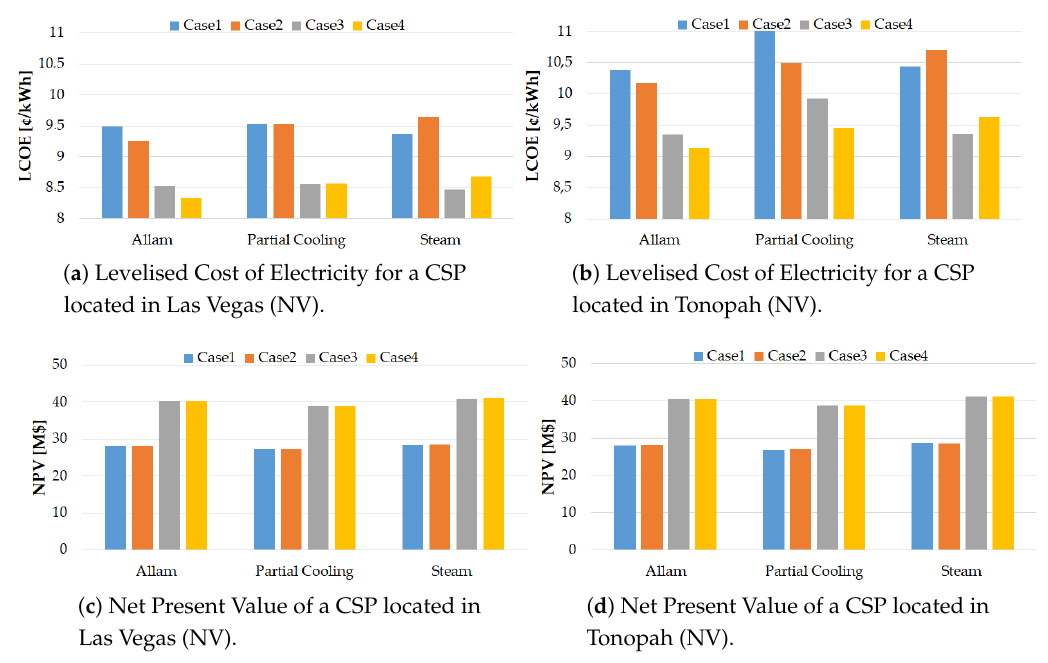
Figure 8. Levelised Cost of Electricity and Net Present Value of the three different cycles and four combinations of financial/dispatch control settings. Two locations in Nevada are considered: Las Vegas and